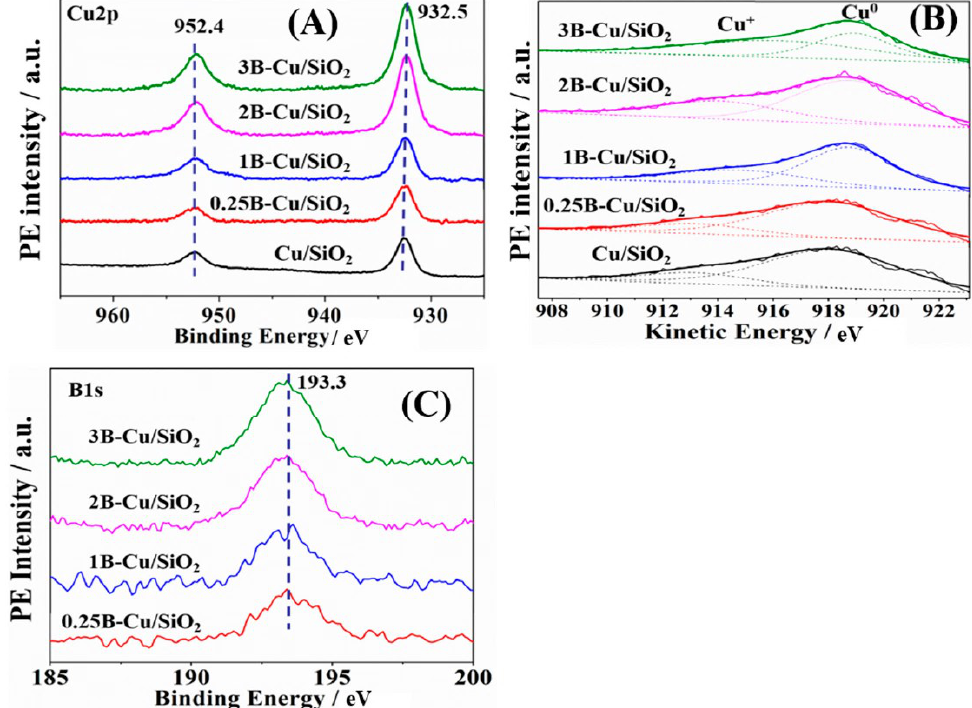
Figure 4. ( A ) Cu2p XPS spectra ( B ) Cu LMM XAES spectra ( C ) B1s XPS spectra of x B-Cu/SiO 2